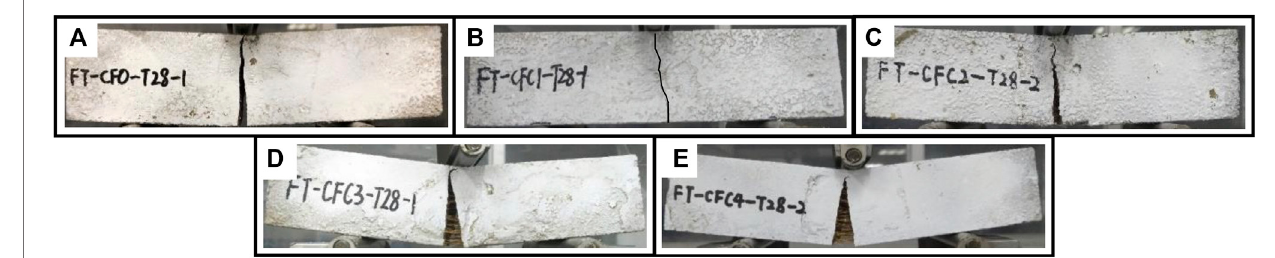
FIGURE 4 | Failure patterns (A) F1; (B) F2; (C) F3; (D) F4; (E)